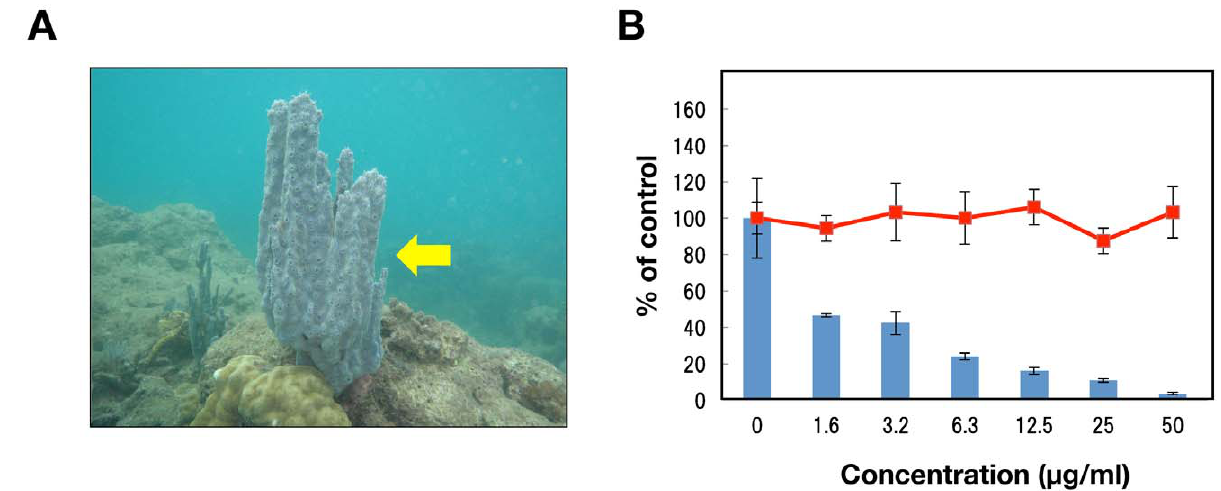
Figure 1. Effect of the extract prepared from a marine sponge on viral replication in the replicon cell line derived from viral genotype 1b. (A) Amphimedon sp. belongs to a marine sponge. The ethyl acetate fraction prepared from the marine organism was designated C- 29EA in this study. (B) The Huh7 cell line, including the subgenomic replicon RNA of genotype 1b strain Con1, was incubated in medium containing various concentrations of C-29EA or DMSO (0). Luciferase and cytotoxicity assays were carried out as described in Materials and Methods. Error bars indicate standard deviation. The data represent three independent experiments.